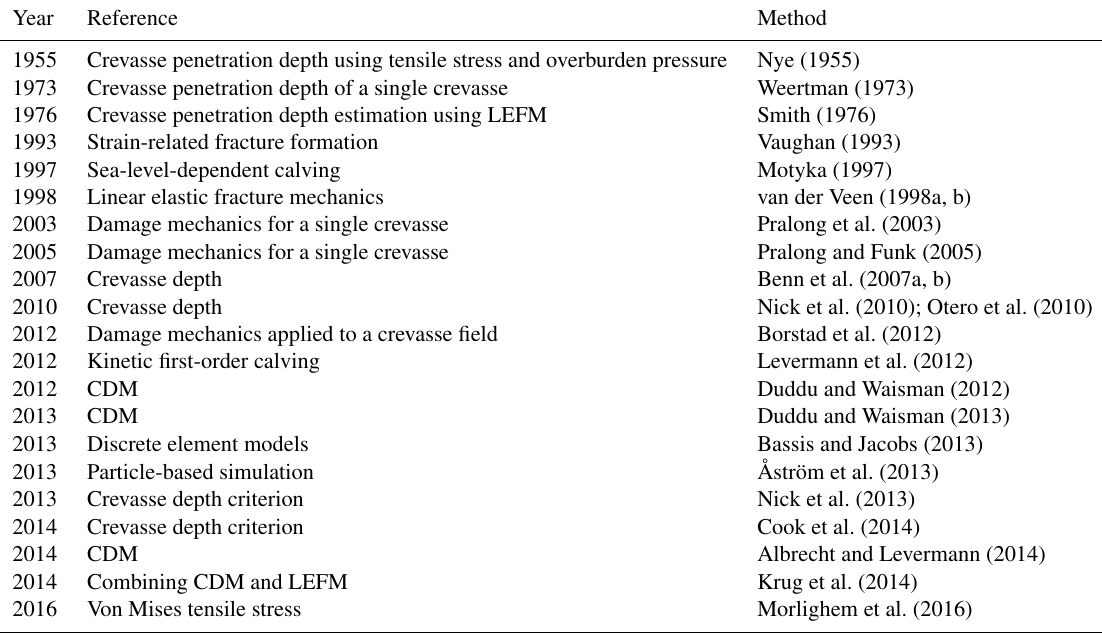
Table 1. Development of calving